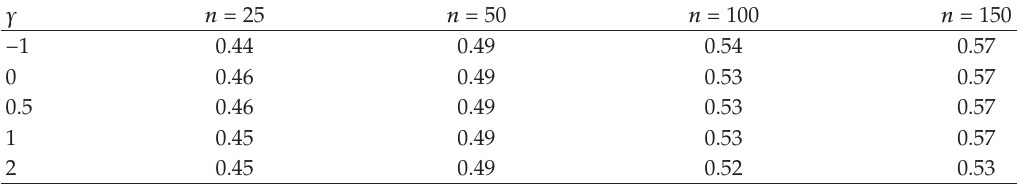
Table 12: Empirical coverage probabilities for the exponential distribution under right censoring, 20% of